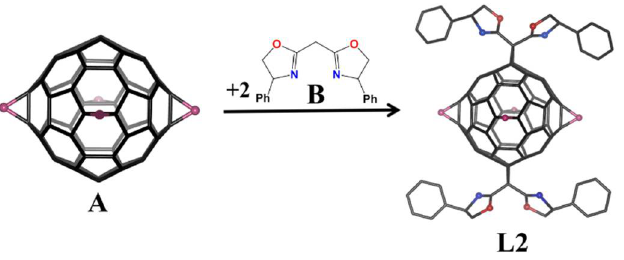
Scheme 1. Synthesis of the trans -1 bis[(4S)-4-phenyl-2-oxazoline] adduct of C 60 -tetramalonate, L2